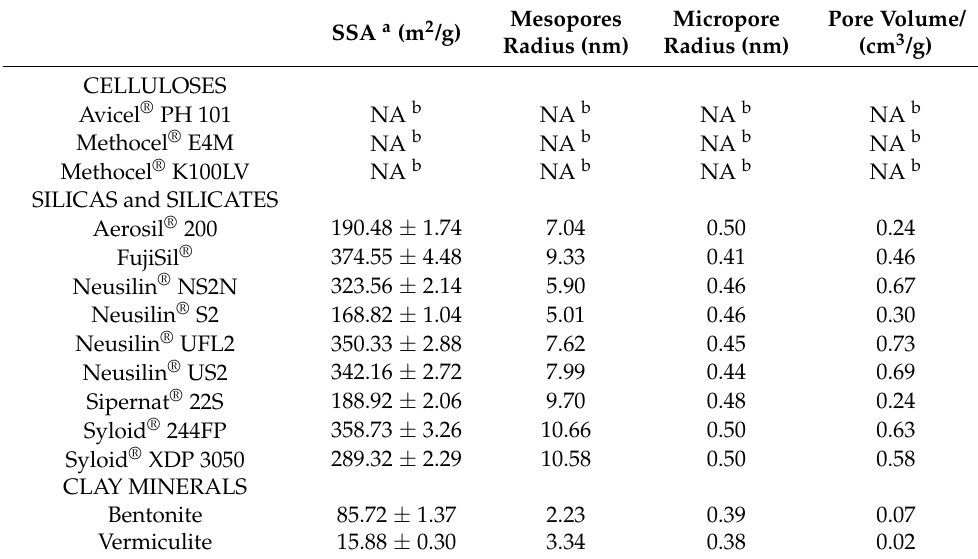
Table 2. Specific surface area, and values for mesopores, micropores, and pore